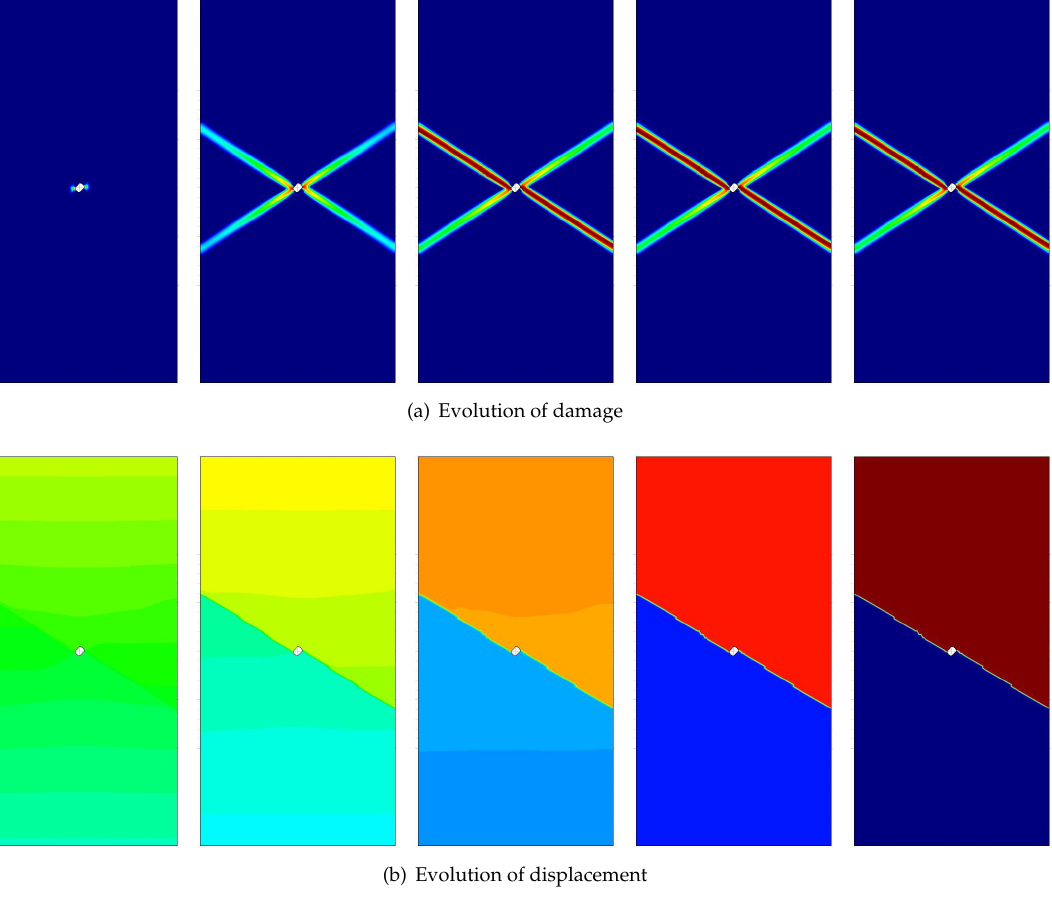
Figure 10. Uniaxial tension of a perforated strip: Simó and Ju [45] damage model in the plane strain condition. Figure 8. Uniaxial tension of a perforated strip: evolution of damage and vertical displacements for the Simó and Ju [41] model in the case of plane strain with Poisson’s ratio ν 0 =